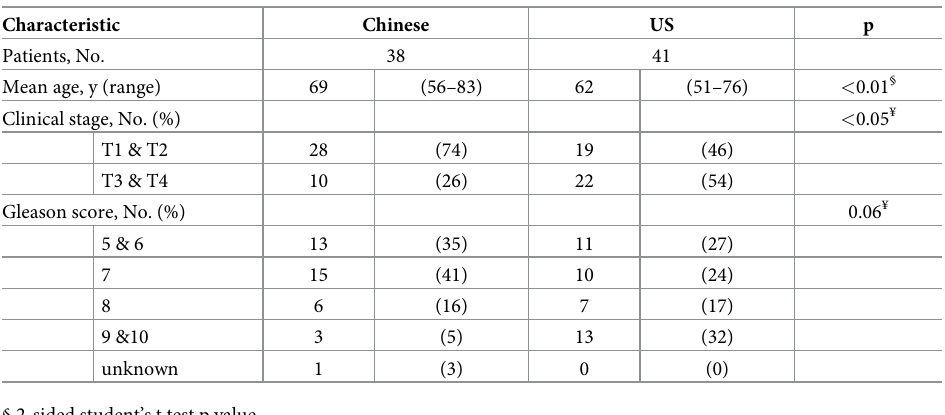
Table 2. Characteristics of patients from China and the US. Characteristic Chinese US p Patients, No. Mean age, y (range) Clinical stage, No. (%)